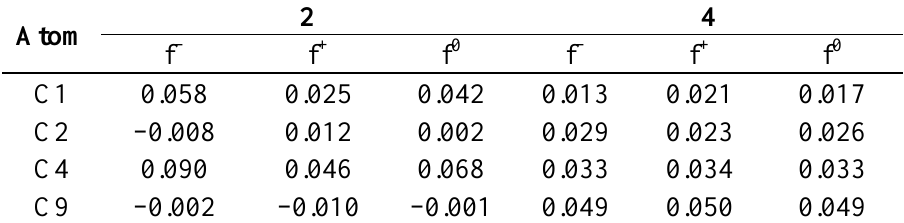
Table 4. Fukui indexes f + , f– and f 0 for selected atoms (for notation refer to Scheme 1).